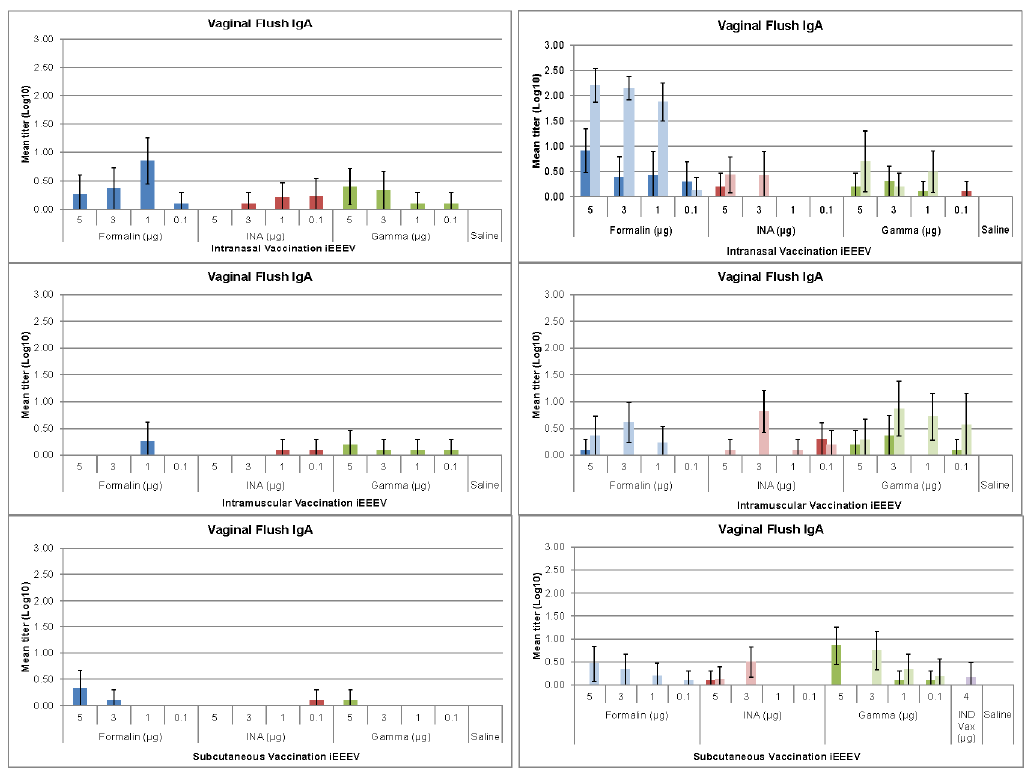
Figure 7. Vaginal flush IgA antibody responses in mice vaccinated with iEEEV vaccine candidates. Groups of BALB/c mice (n=10) were vaccinated once (graphs on left) or twice (graphs on right) with one of three iEEEV vaccine candidates (formalin-inactivated, INA-inactivated, or gamma irradiated) at doses ranging from 0.1–5 m g by the IN, IM, or SC route. Vaginal flush samples were collected 21 d after each vaccination and virus specific IgA antibody levels were determined by ELISA. In all graphs, dark bars represent the mean group titer 21 days after the first vaccination (n=10); light bars represent the mean group titer 21 days after the second vaccination (n=10). Standard error bars represent 2 times the SE of the mean (SE=SDxsqrt(n)).